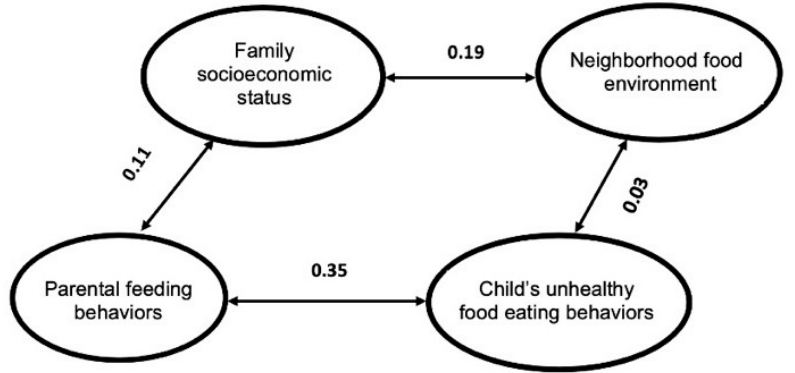
Figure A1. Multicollinearity Analysis.